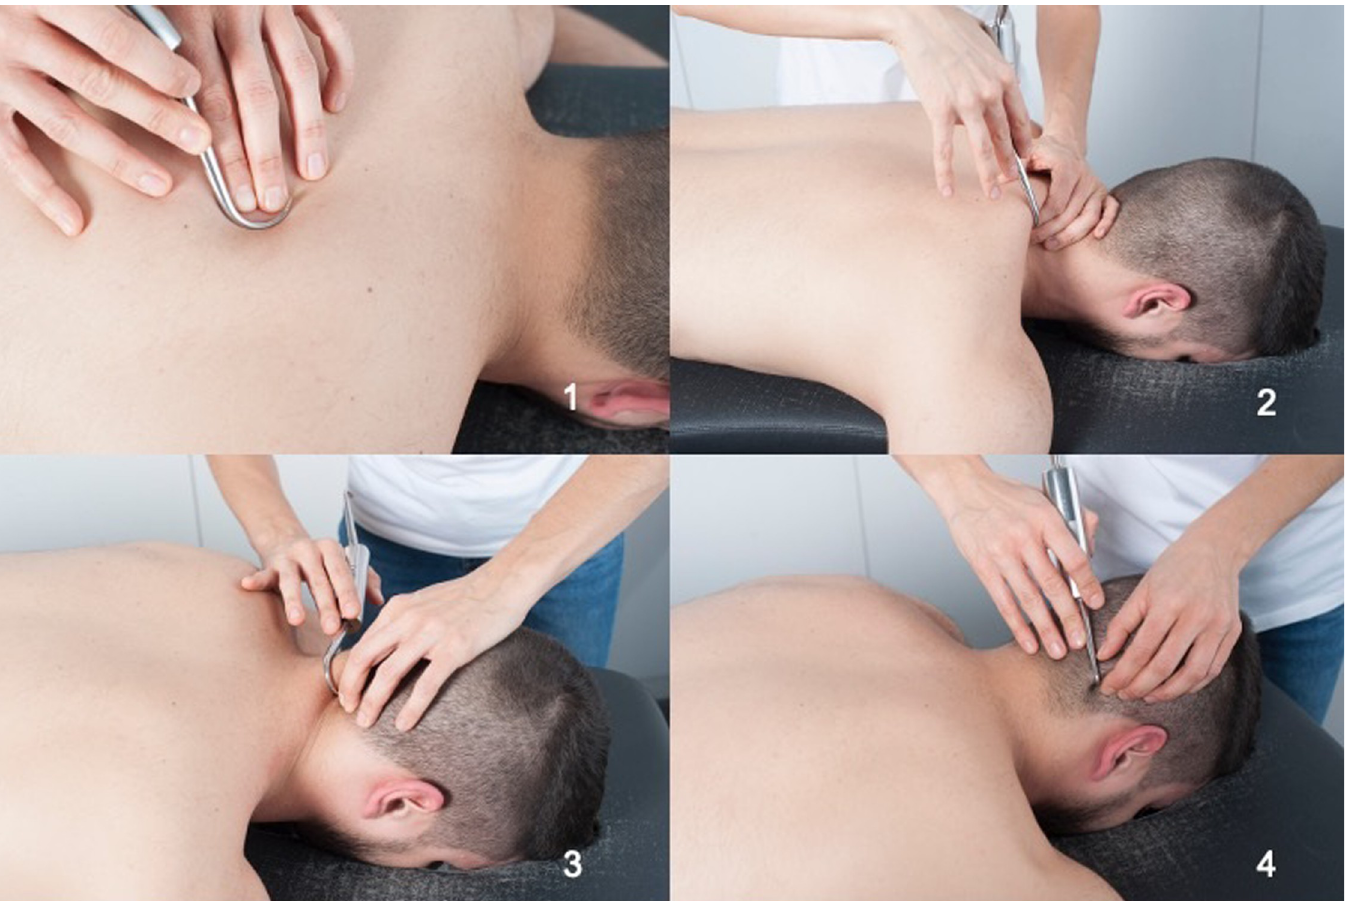
Fig 2. Diacutaneous fibrolysis techniques. 1. Treating painful points by pressure inhibition, 2 and 3. Separating different muscle planes and 4. Scratching tendon attachments.